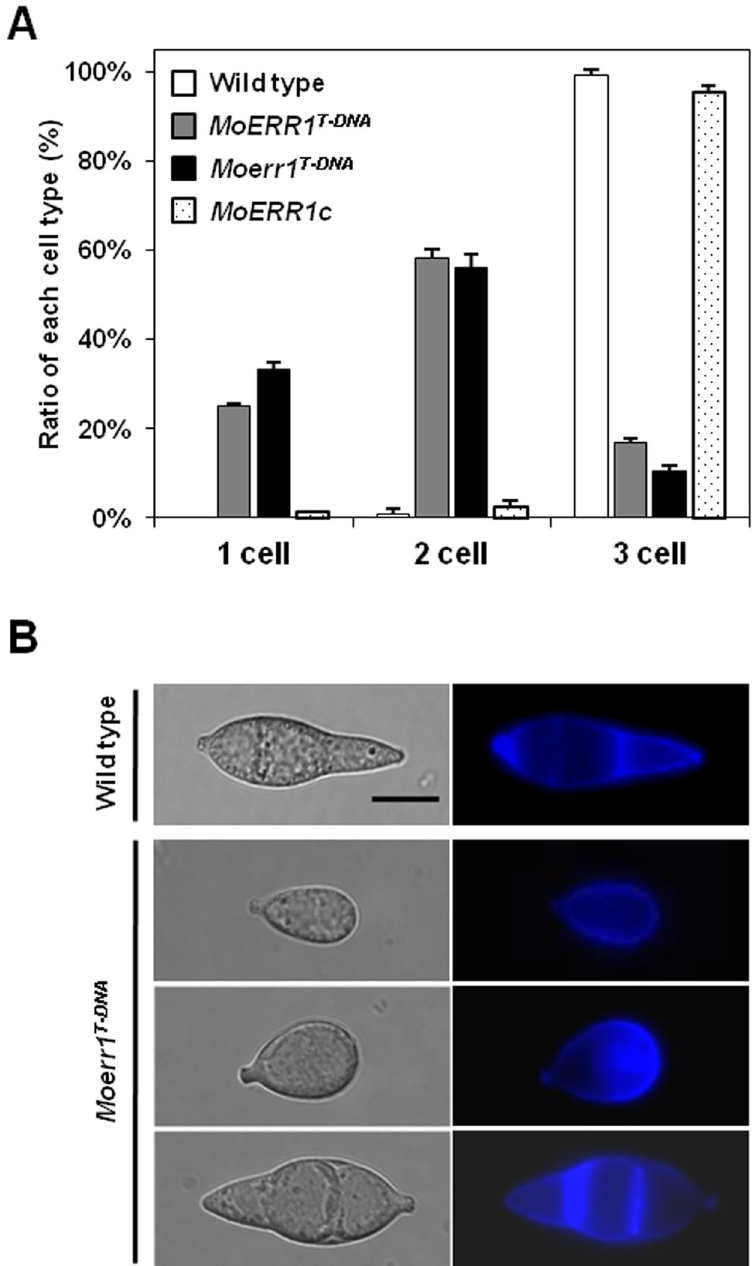
Figure 5. Conidia morphology of Moerr1 T-DNA . ( A ) Distribution of conidia type by cell number. Each ratio of conidia types were calculated with more than 100 conidia examined by 3 replications. ( B ) Cell morphology. Conidial cell wall were stained by calcofluore white, and observed using a 4 ′ ,6-diamidino-2-phenylindole filter after incubation for 10 minutes. Bar = 10 μ